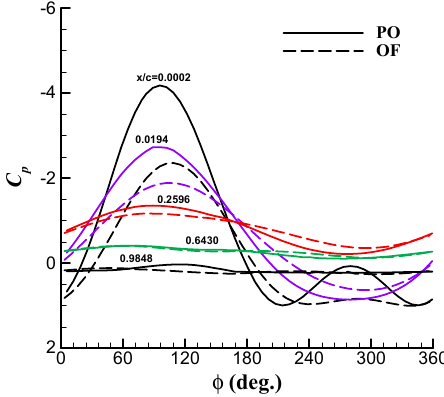
Figure 13. Comparison of unsteady pressures at different chordwise locations on the upper surface between pitch oscillation and oscillating freestream. α m = 2°, A = 8°, and k = 0.078. The same locations